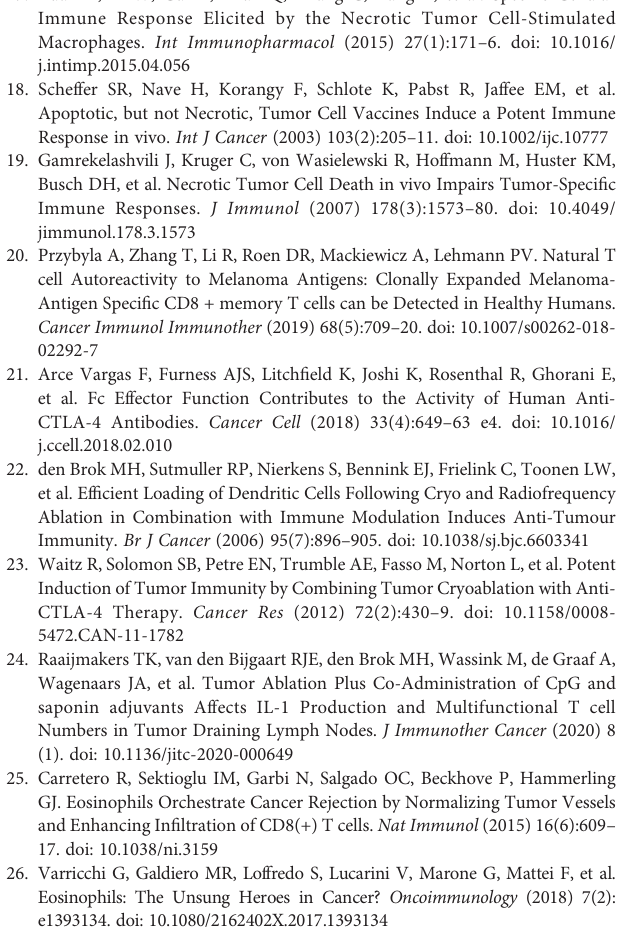
Supplementary Table 6 | Differences in percentages of immune cell populations between experimental groups at day 8 post cryoablation in tumors. Data was analyzed using non-parametric Mann-Whitney U test. NS, not signi fi cant. Higher ( ↑ ) or lower ( ↓ ) post cryoablation than non-treated controls (columns 1 and 2). Higher ( ↑ ) or lower ( ↓ ) post fast freeze than slow freeze group (column